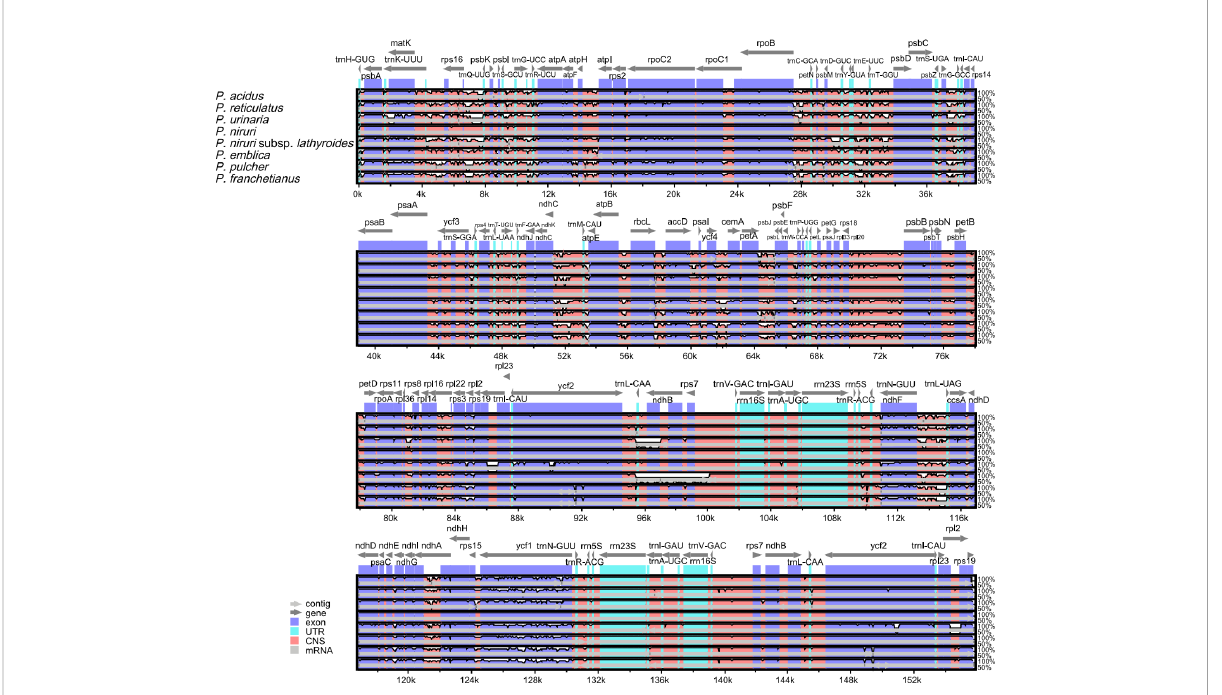
FIGURE 4 Comparison of nine cp genomes using P . amarus annotation as a reference. The vertical scale indicates the percentage of identity, ranging from 50% to 100%. The horizontal axis shows the coordinates within the cp genome. Genome regions are color-coded as exons, introns, and IGS, and the gray arrows indicate the direction of transcription of each gene. Annotated genes are displayed along the